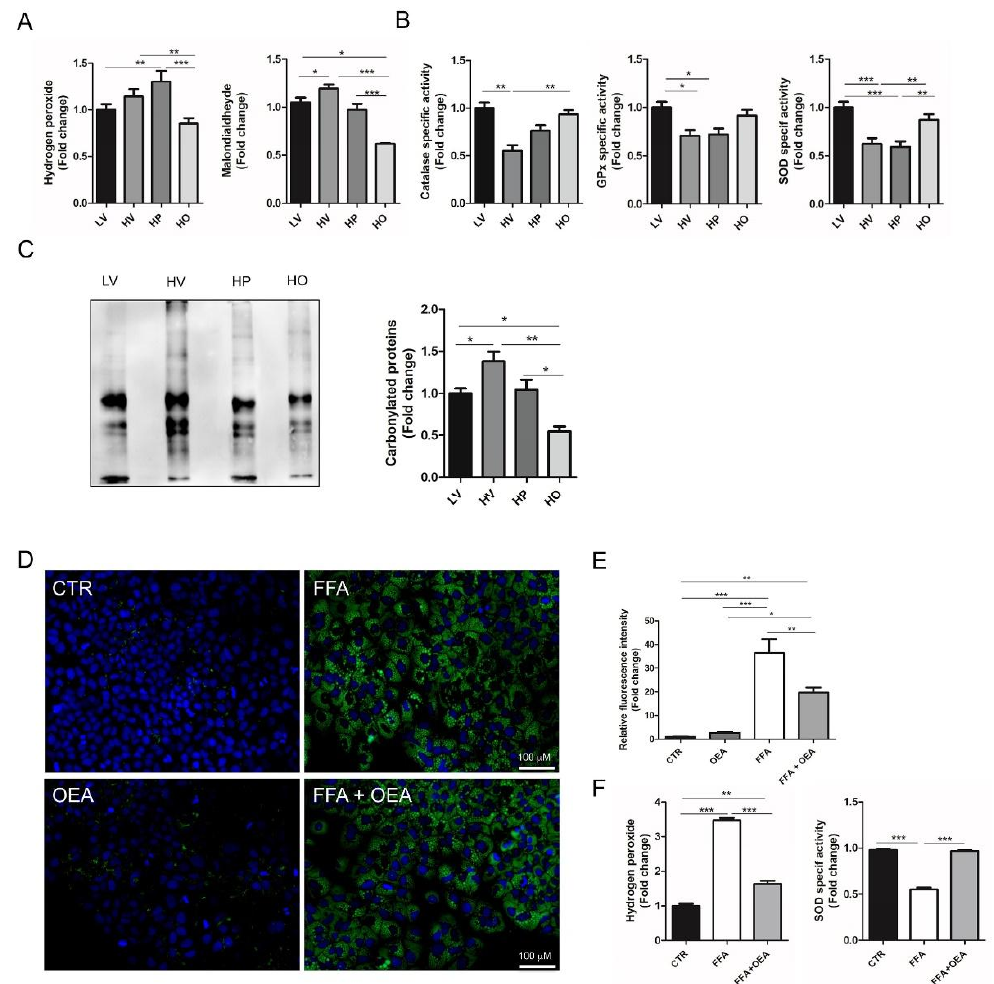
Figure 2. OEA modulated oxidative stress in vivo and in vitro. ( A ) Hydrogen peroxide and malondialdehyde measurements were done as reported in Materials and Methods. Values, expressed in fold change of LV, are the mean ± SEM of five different samples. ( B ) Catalase, glutathione peroxidase (GPx), and superoxide dismutase (SOD), specific activities were assayed in liver homogenates as reported in Materials and Methods. Values, expressed in fold change of LV, are the mean ± SEM of five different samples. ( C ) Representative immunoblot for carbonylated proteins and relative quantification. Values, expressed in fold change of LV, are the mean ± SEM of three different samples. ( D ) Representative images of Huh7 cells treated with BSA (CTR), BSA and OEA (OEA) or with a mix of palmitate-oleate (FFA) in BSA at 500 μ M final concentration alone or in combination with OEA as described. Cells were stained with BODIPY 493/503 (lipid droplets, green), and Hoechst 33342 (nucleus, blue), scale bar is 100 μ m. Fluorescence images were captured using an EVOS FLoid Imaging System. ( E ) Fluorescence intensity for each image was quantitated using Image J software and normalized respect to total number of nuclei. The fluorescence intensity, relative to CTR, is shown and expressed as mean ± SEM ( n = 4). ( F ) Hydrogen peroxide and SOD activity were assayed in CTR, FFA, and FFA+OEA. Values, expressed in fold change of CTR, are the mean ± SEM of five different experiments. * p < 0.05; ** p < 0.005; *** p < 0.001.